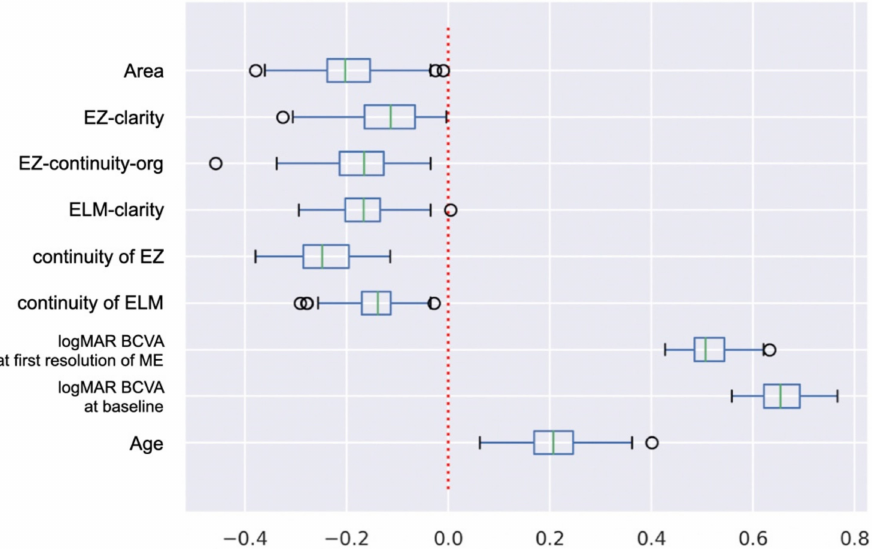
Figure 6. Box and whisker diagrams with outliers showing coefficients of explanatory variables. Max- imal and minimal whisker lengths are set to the upper and lower limits of 1.5 times the interquartile range (IQR). First quartile − 1.5 × IQR is the lower limit of the whisker, and third quartile + 1.5 × IQR is the upper limit of the whisker. Values smaller than the lower end of the whisker or larger than the upper end of the whisker are indicated by circles as